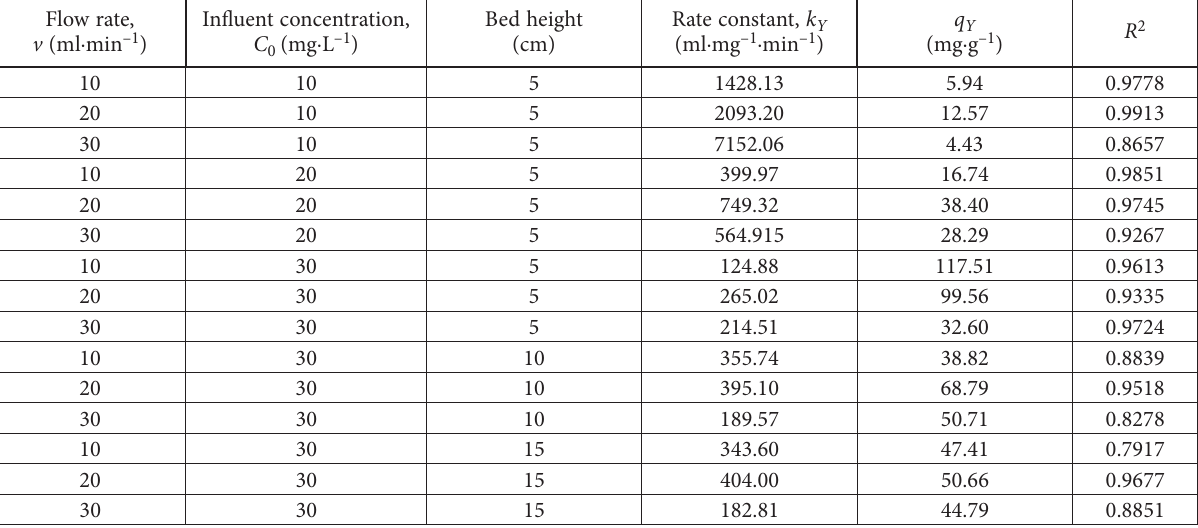
Table 5. Yan et al. model parameters using linear regression